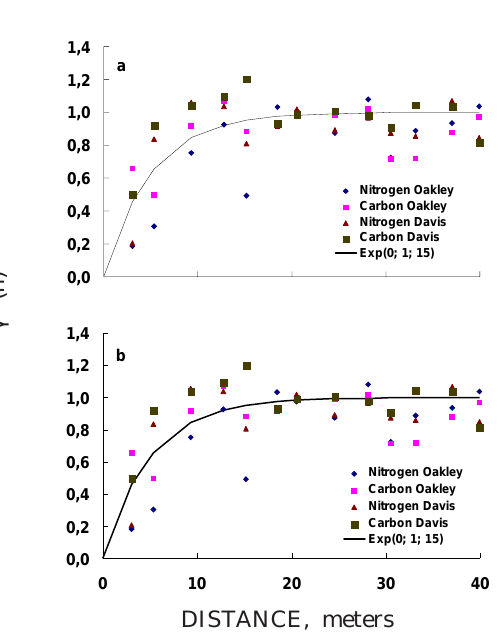
DISTANCE, meters Figure 5. Scaled semivariograms for the carbon and nitrogen at Oakley and Davis. a) Scaling factor equals the sill of individual semivariograms. b) Scaling factor equals the calculated variance of each property.